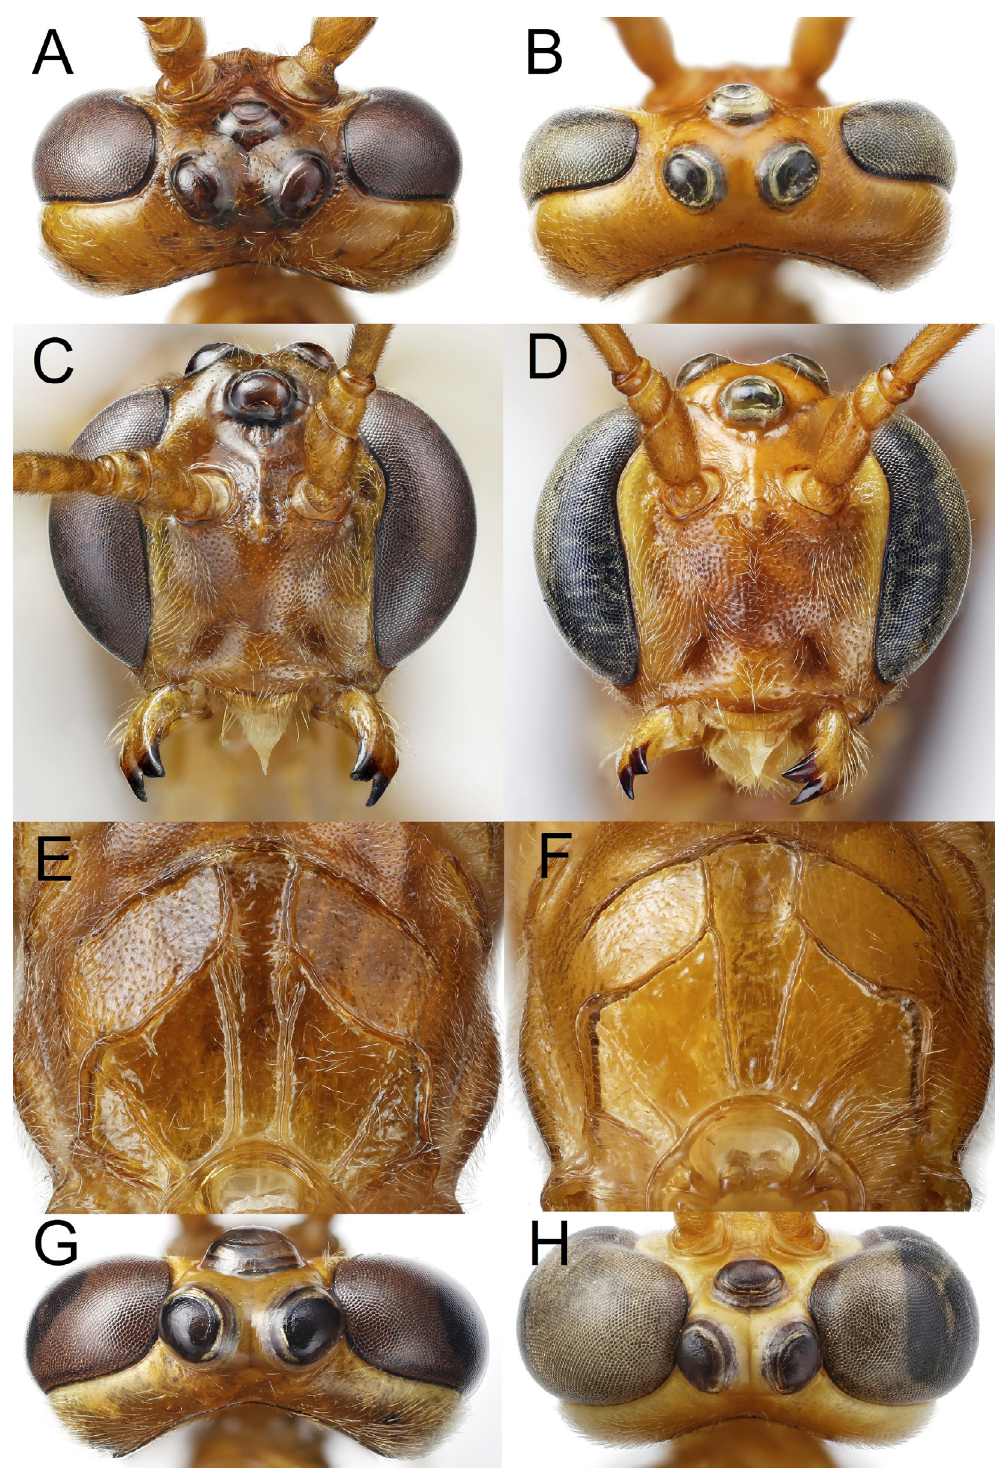
Fig. 18. A–B . head, dorsal view of female. A . Ophion brevicornis Morley, 1915. B . O. subarcticus hellén, 1926. C–D . head anterior view of female. C . O. brevicornis . D . O. subarcticus . E–F . Propodeum posterodorsal view of female. E . O. matti Johansson sp. nov., paratype, ♀ (NHRS-HEVA000008679). F . O. ellenae Johansson sp. nov., paratype, ♀ (NHRS-HEVA000008655). G–H . head in dorsal view of Ophion pteridis Kriechbaumer, 1879. G . Female. H .